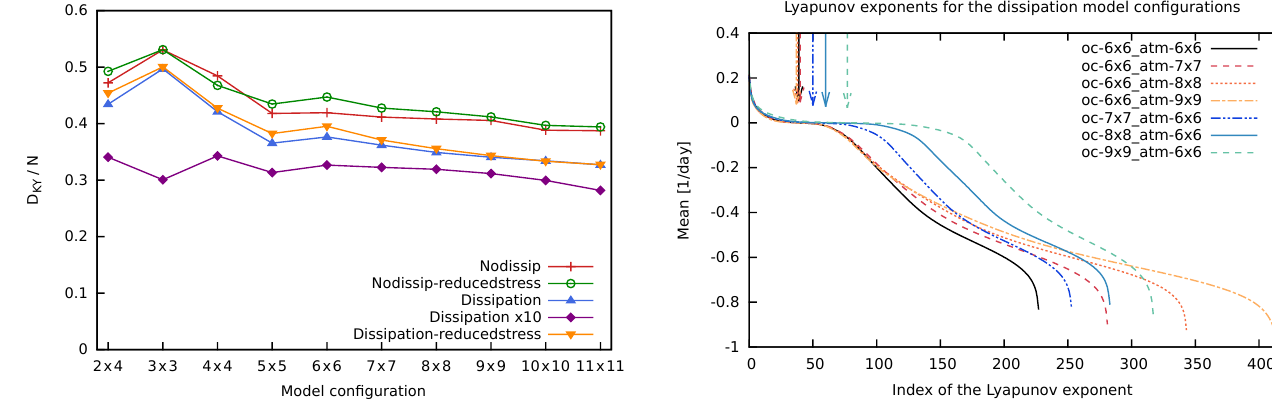
Figure 16. Kaplan–Yorke or Lyapunov dimension D KY of MAOOAM divided by the total number of dimensions N , as a func- tion of the resolution for the different experiments. Colours as in Fig. 10.